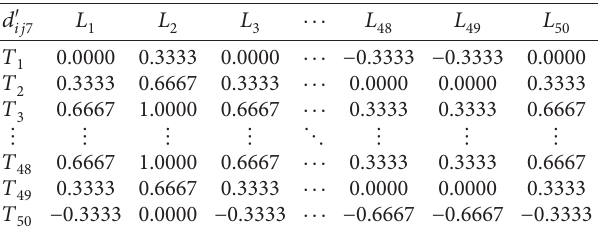
Table 35: Perceived utility matrix V b ′ � [ d ij ′ ] for 7 7 50 × 50 housing online ratings.